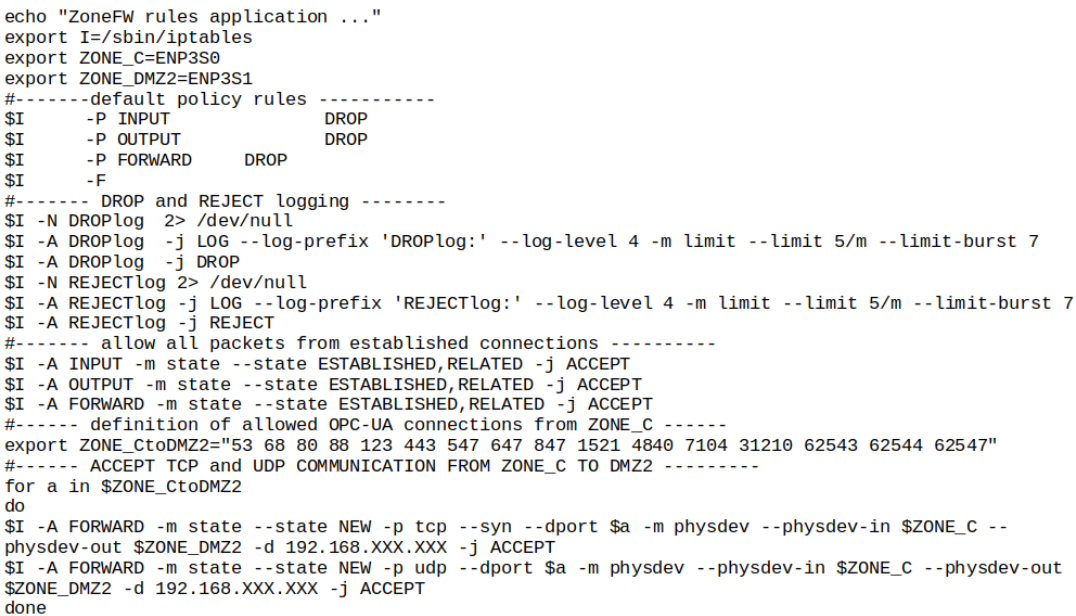
Figure 15. Example of data transfers within an OPC UA system.